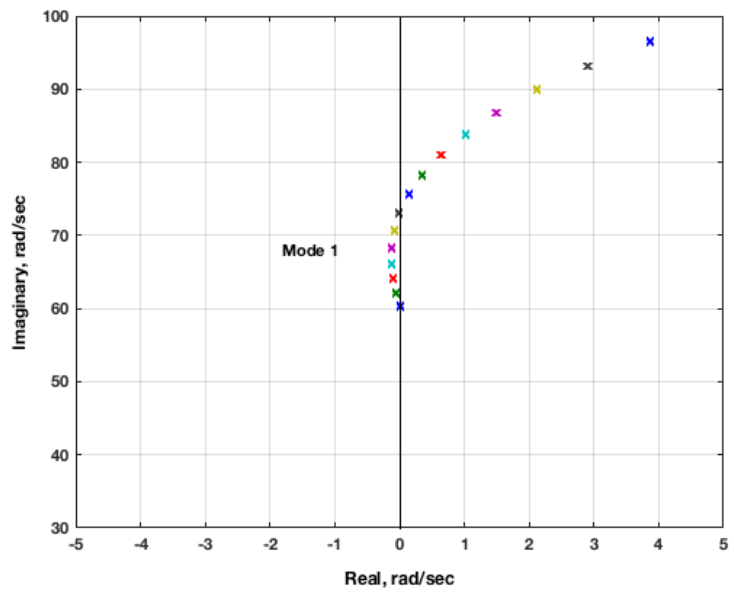
Figure 17. Detailed view of ROM aeroelastic root locus plot for M = 0.96, inviscid solution.